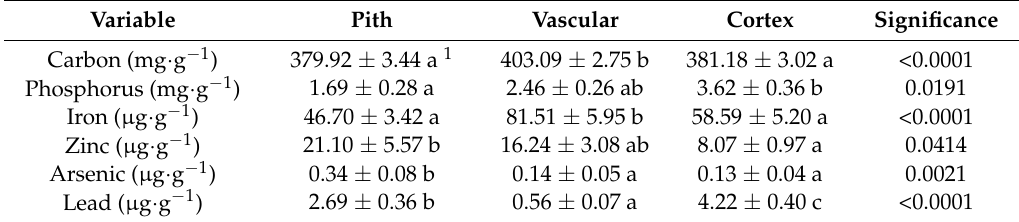
Table 1. The influence of radial position within Cycas micronesica stems on mineral and metals. Means are a combination of apical and basal stem regions. Data were presented as mean ± standard error for n =